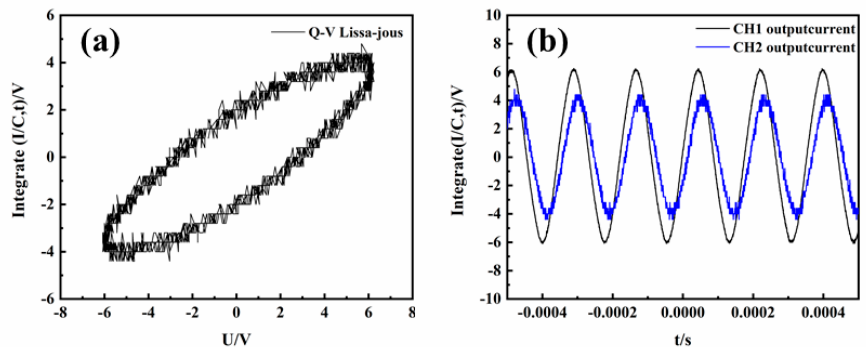
Figure 9. ( a ) Q-V Lissajous Graphics; ( b ) Power output voltage data saved by oscilloscope. (Filled with 600 mg catalysts and the input power of 120